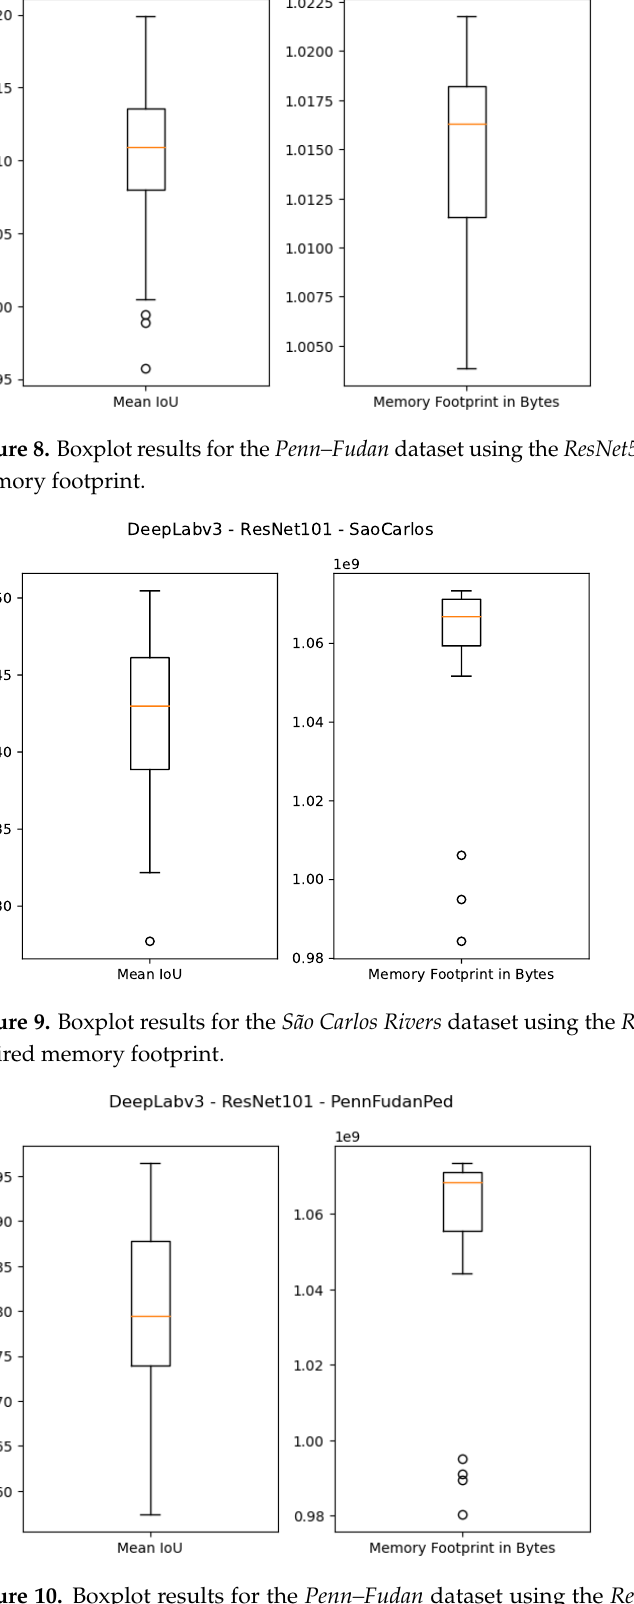
Figure 10. Boxplot results for the Penn–Fudan dataset using the ResNet101 backbone and 1 GB of desired memory